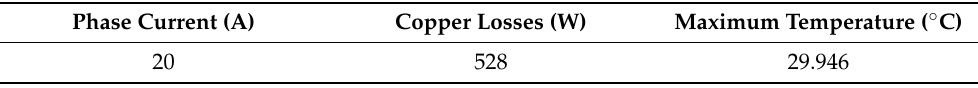
Table 4. The loss parameters for the thermal analysis.